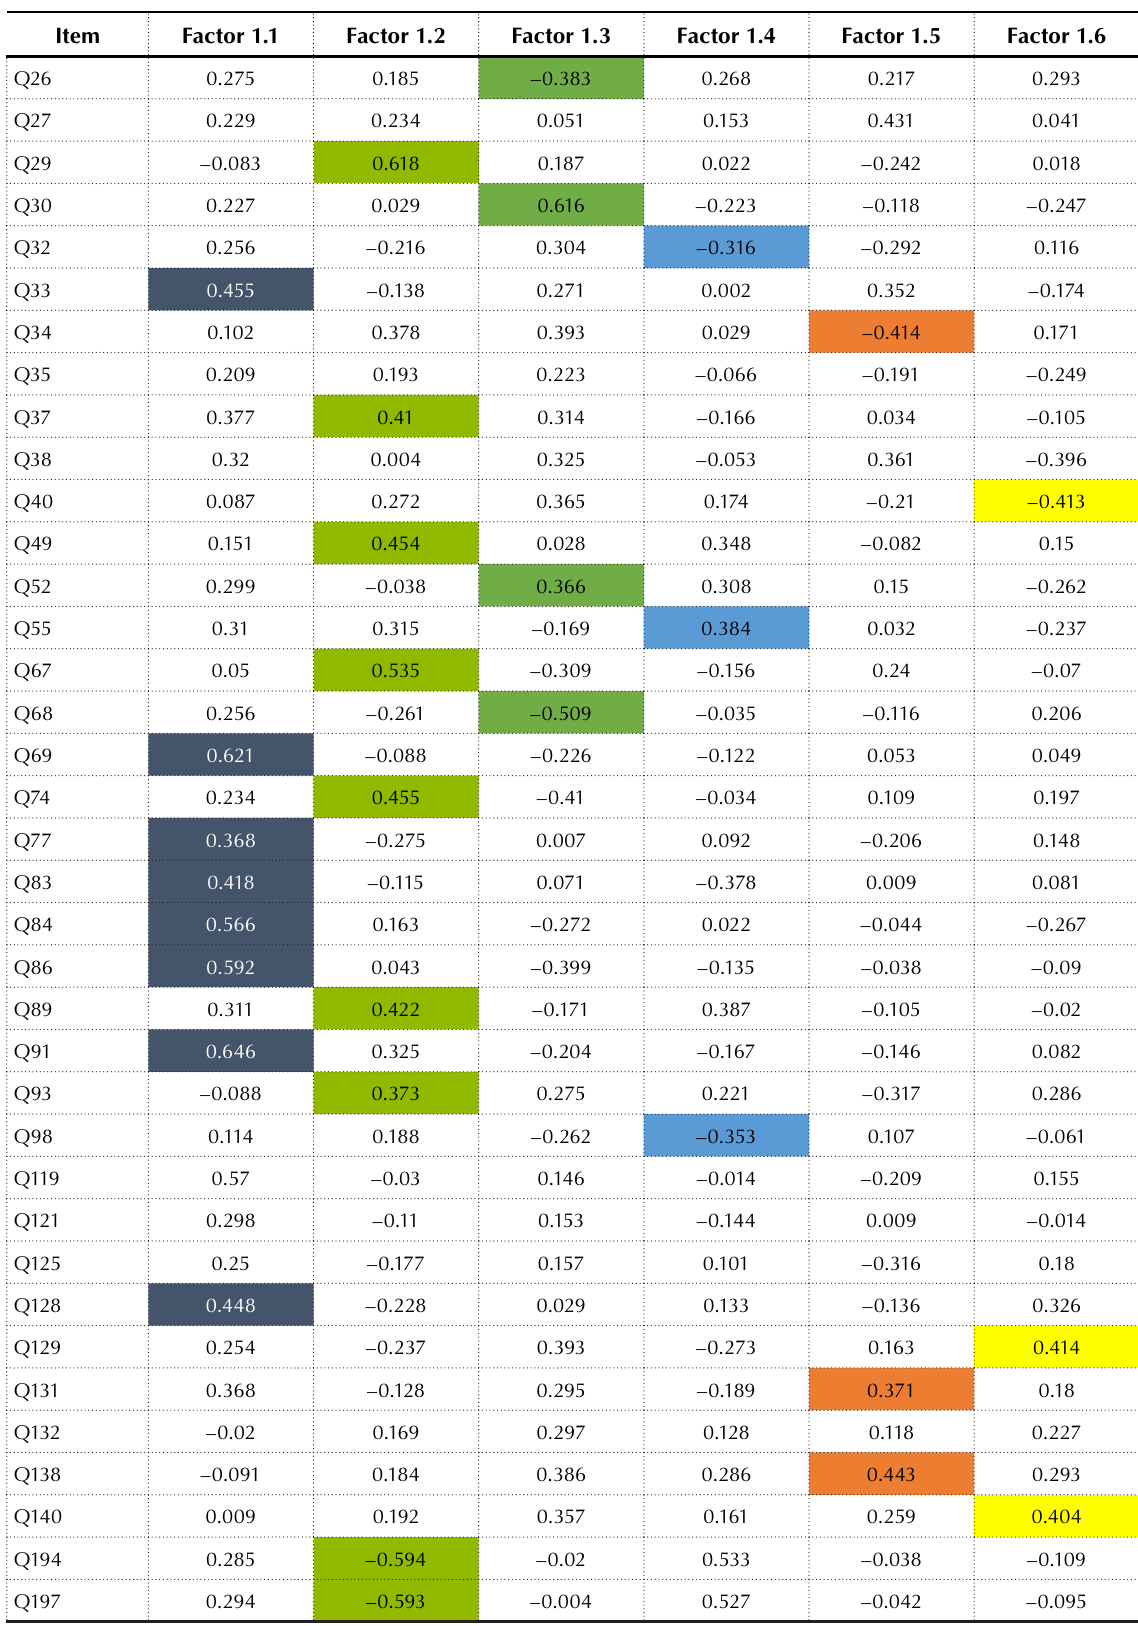
Table 4. Initial solution on the